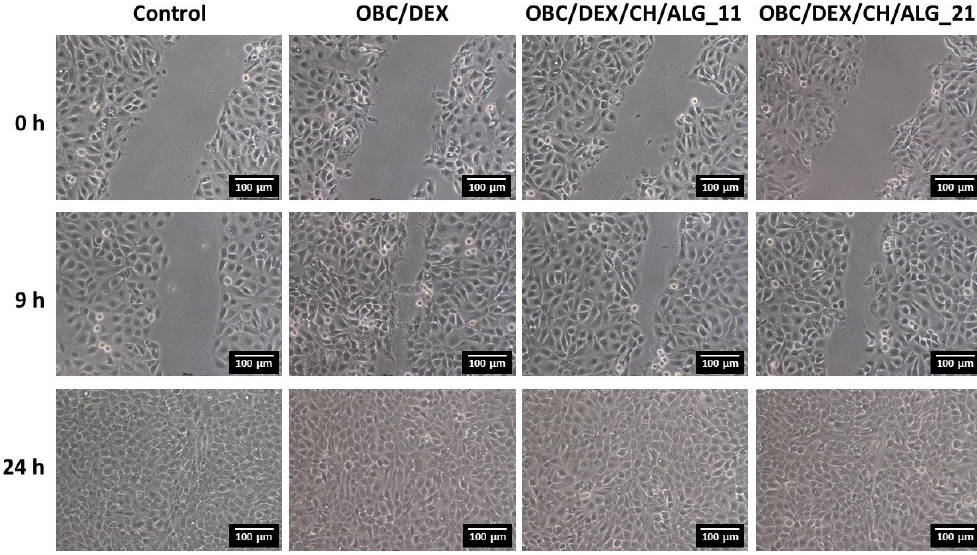
Figure 6. Optical micrographs of the scratch assay of the HaCaT cells after 9 and 24 h of exposure to control, OBC/DEX, OBC/DEX/CH/ALG_11, and OBC/DEX/CH/ALG_21 patches.